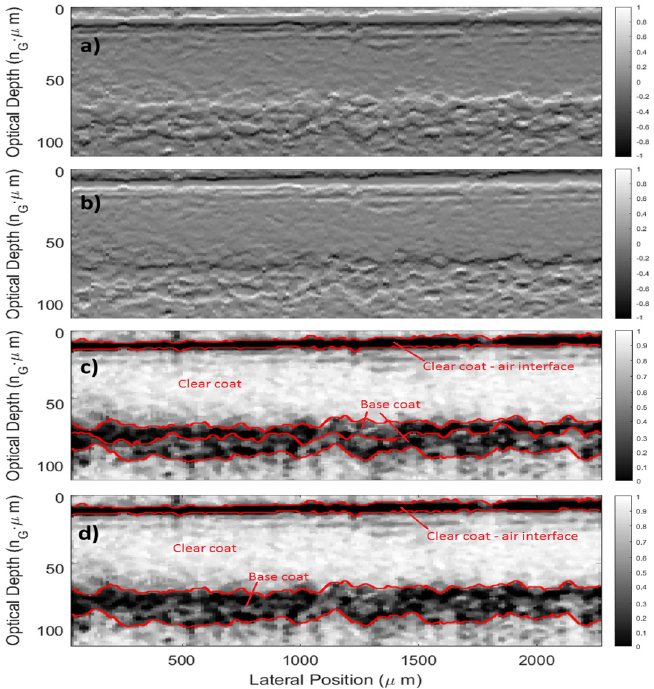
Figure 5. Segmentation process of LF-OCT B-scan of silver car paint sample. ( a , b ) The joint energy functional used to find the initial contours; ( c ) The initial result using graph-search segmentation; ( d ) The result after automated removal of the phantom contour.